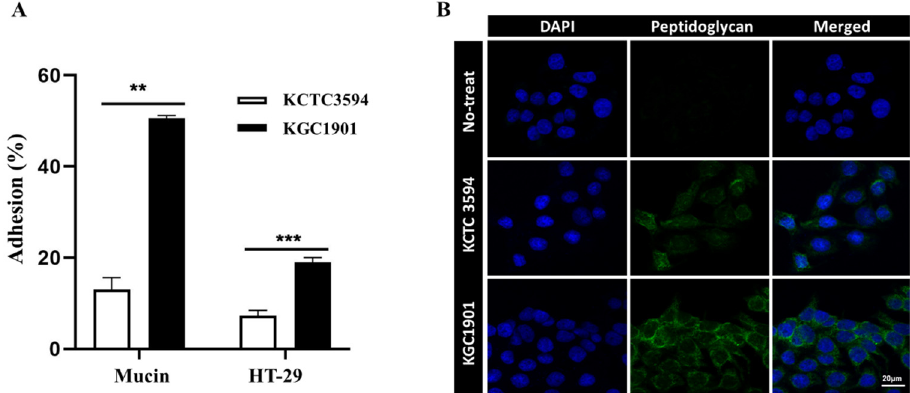
Figure 3. Adhesion ability and immunofluorescent image of L. reuteri KGC1901. ( A ) Adhesion ability of L. reuteri KGC1901 and L. reuteri KCTC3594 (positive control) to mucin and HT-29 cells. Data are presented as mean ± standard deviation values from triplicate experiments. Significant correlations between the two strains are shown by asterisks (** p < 0.01, and *** p < 0.001). ( B ) HT-29 cells were stained with DAPI (blue), and the bacterial cells of L. reuteri KGC1901 and L. reuteri KCTC3594 were stained with antibodies against peptidoglycan and goat anti-mouse Alexa fluor 488